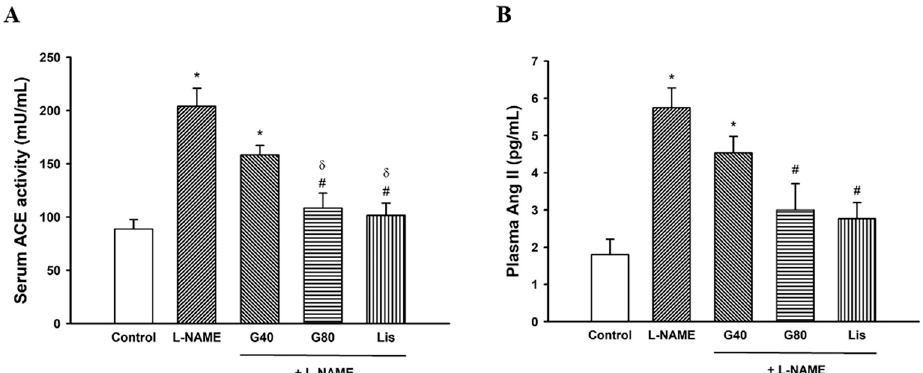
Figure 4. Effect of genistein or lisinopril on serum ACE activity ( A ) and plasma Ang II ( B ) in rats treated with L-NAME. Data are expressed as mean ± SEM. * p < 0.05 vs. control, # p < 0.05 vs. L-NAME, and δ p < 0.05 vs. G40 ( n = 8/group). ACE, angiotensin-converting enzyme; Ang II, angiotensin II; control, normotensive rats; L-NAME, N ω -nitro-L-arginine methyl ester hydrochloride; L-NAME + G40, L-NAME hypertensive rats treated with genistein 40 mg/kg; L-NAME + G80, L-NAME hypertensive rats treated with genistein 80 mg/kg; and L-NAME + Lis, L-NAME hypertensive rats treated with lisinopril 5 mg/kg.